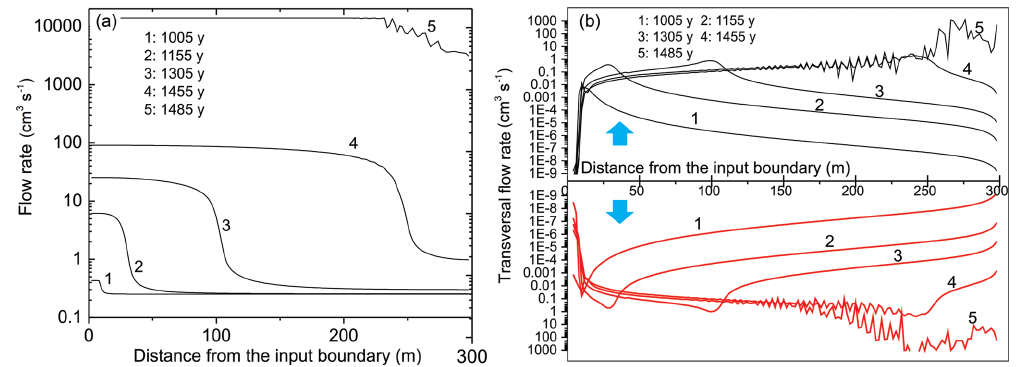
Figure 8. (a) Profiles of flow rates along a wormhole at the given times. (b) Profiles of flow rates from the wormhole into the upper (black) and lower (red) domain at given times.